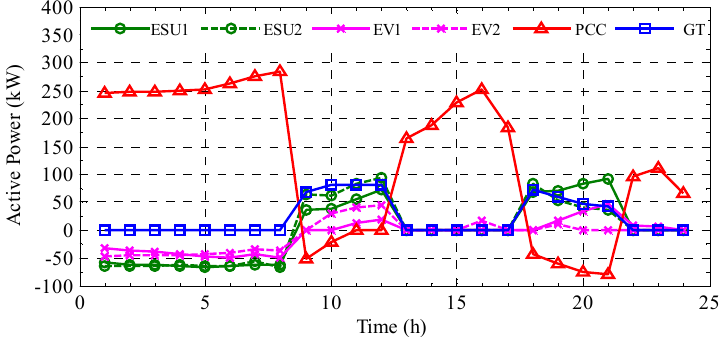
Figure 7. Active power of ESUs, EVs, point of common coupling (PCC) and GT in 24 h.